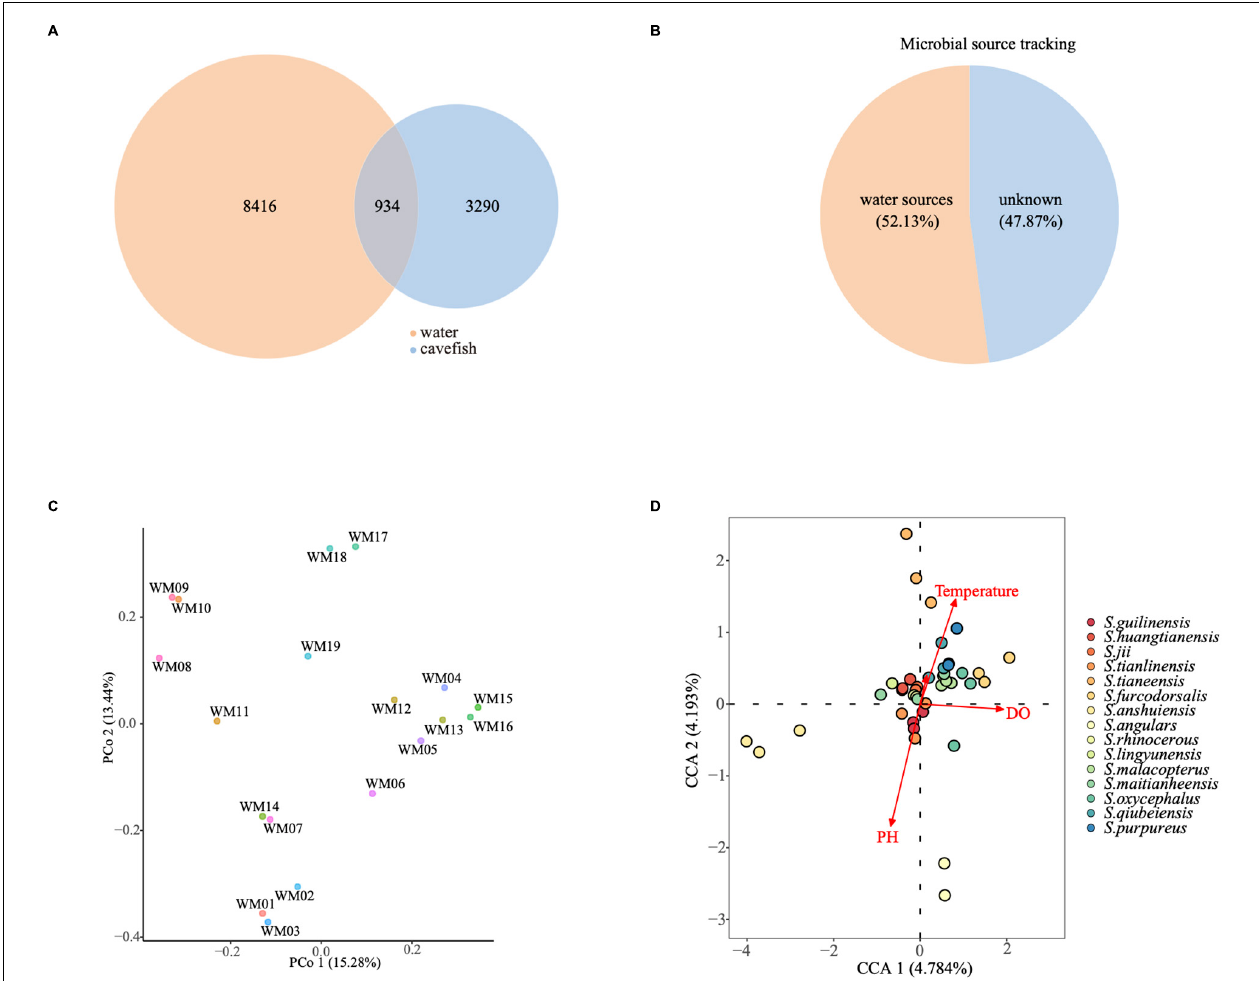
FIGURE 4 | Influence of cave water on the gut microbiome in Sinocyclocheilus species. (A) Number of ASVs shared among cavefishes and water microbiotas. (B) Fast expectation-maximization microbial source tracking. Colors within the circle and area occupied indicate different source in the fecal sample. (C) Unconstrained Principal Coordinate Analysis (Unconstrained PCoA- for principal coordinates PCo1 and PCo2) with Bray–Curtis distance, showing difference between the cave water microbiotas ( N = 19). (D) Water chemistry related changes in the microbial community explained using Canonical correlation analysis